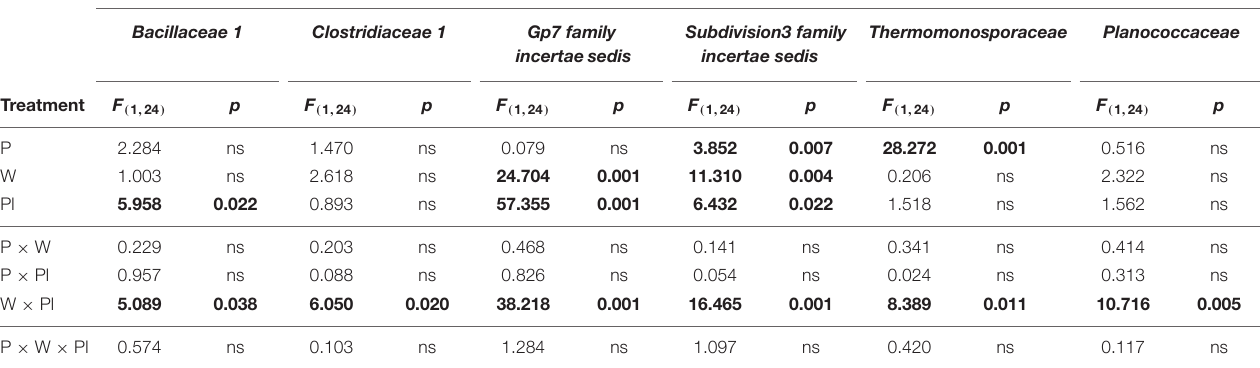
TABLE 3 | Test statistics and p value summary table for bacterial families within the top 25 most relatively abundant that were significantly affected by main and interactive terms across the experiments.